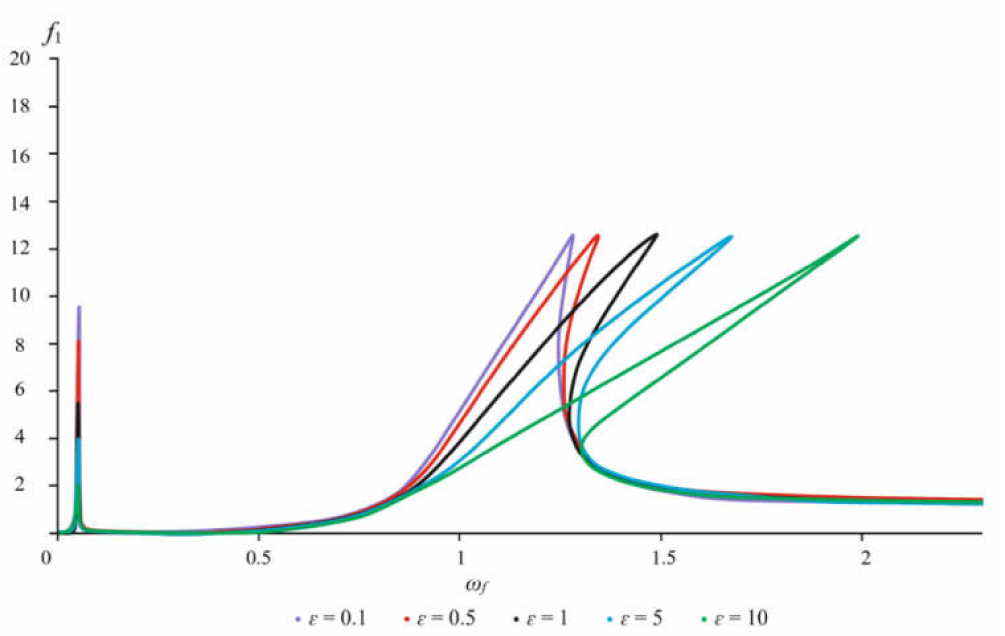
Figure 5. The amplitude-frequency characteristic of the rotor at various degrees of non-linearity.